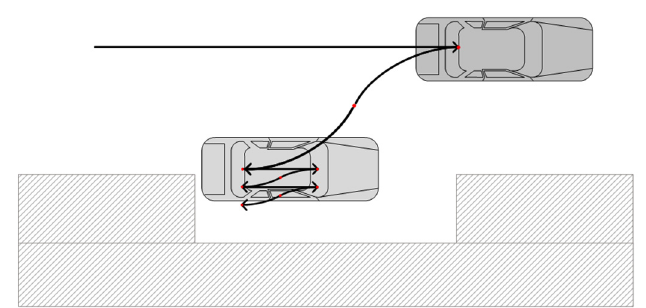
Figure 8. Repetitive parallel parking path.